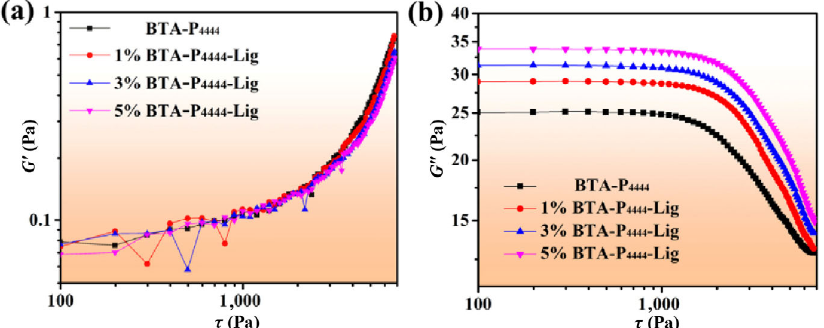
Fig. 3 Curves of storage modulus ( G' ) and loss modulus ( G'' ) of lubricating materials with shear